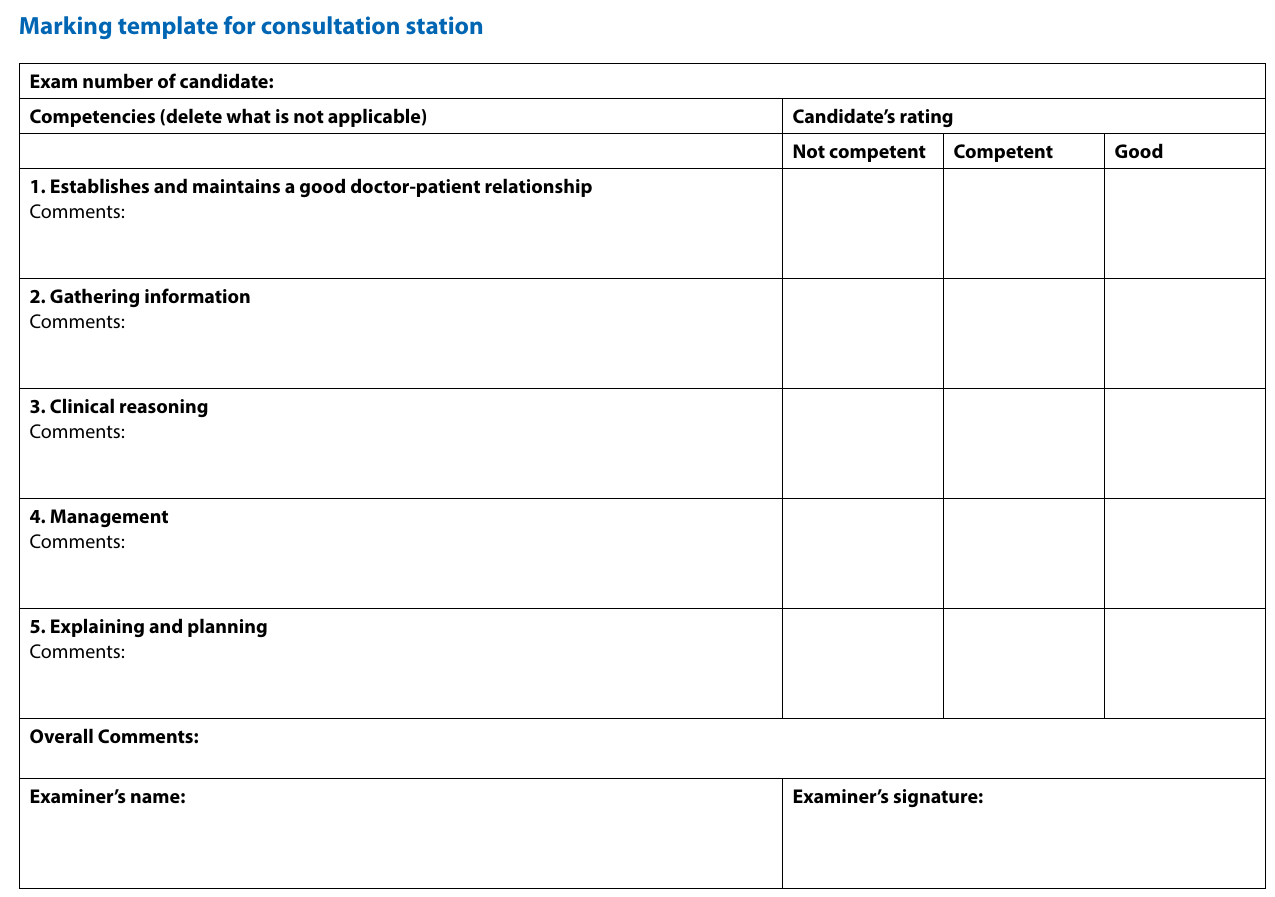
No marks are allocated. In the mark sheet, tick off one of the three responses for each of the competencies listed. Make sure you are clear on what the criteria are for judging a candidate’s competence in each